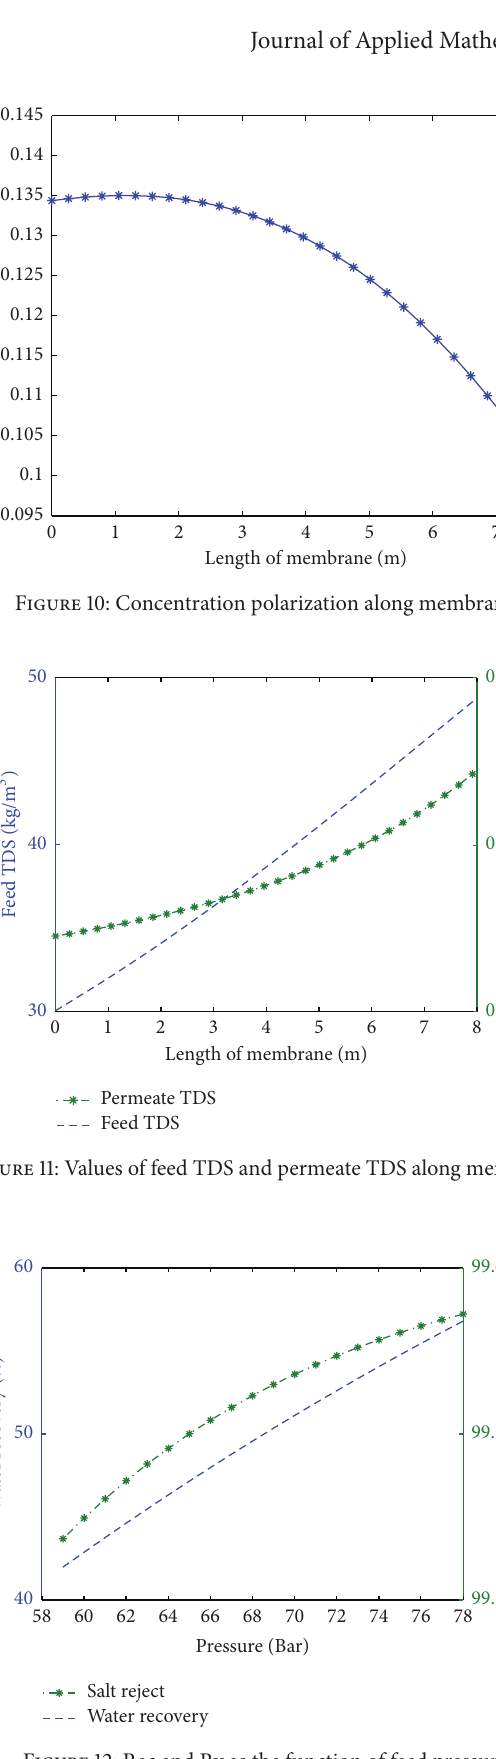
Figure 12: Rec and Ry as the function of feed